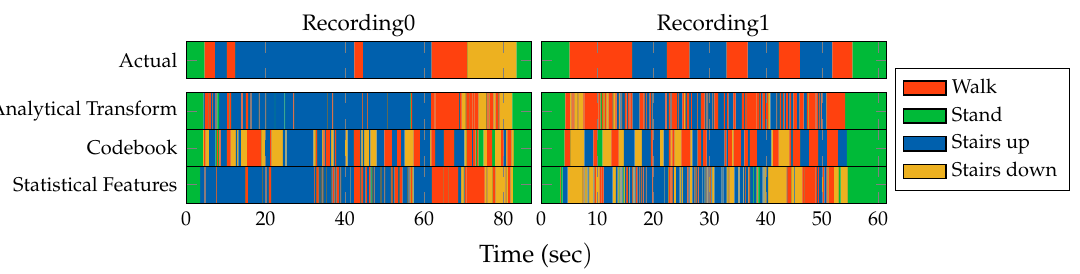
Figure 27. Classification results for two particularly badly classified recordings between all of the three presented procedures in comparison with the actually performed activities (as shown in the first row).